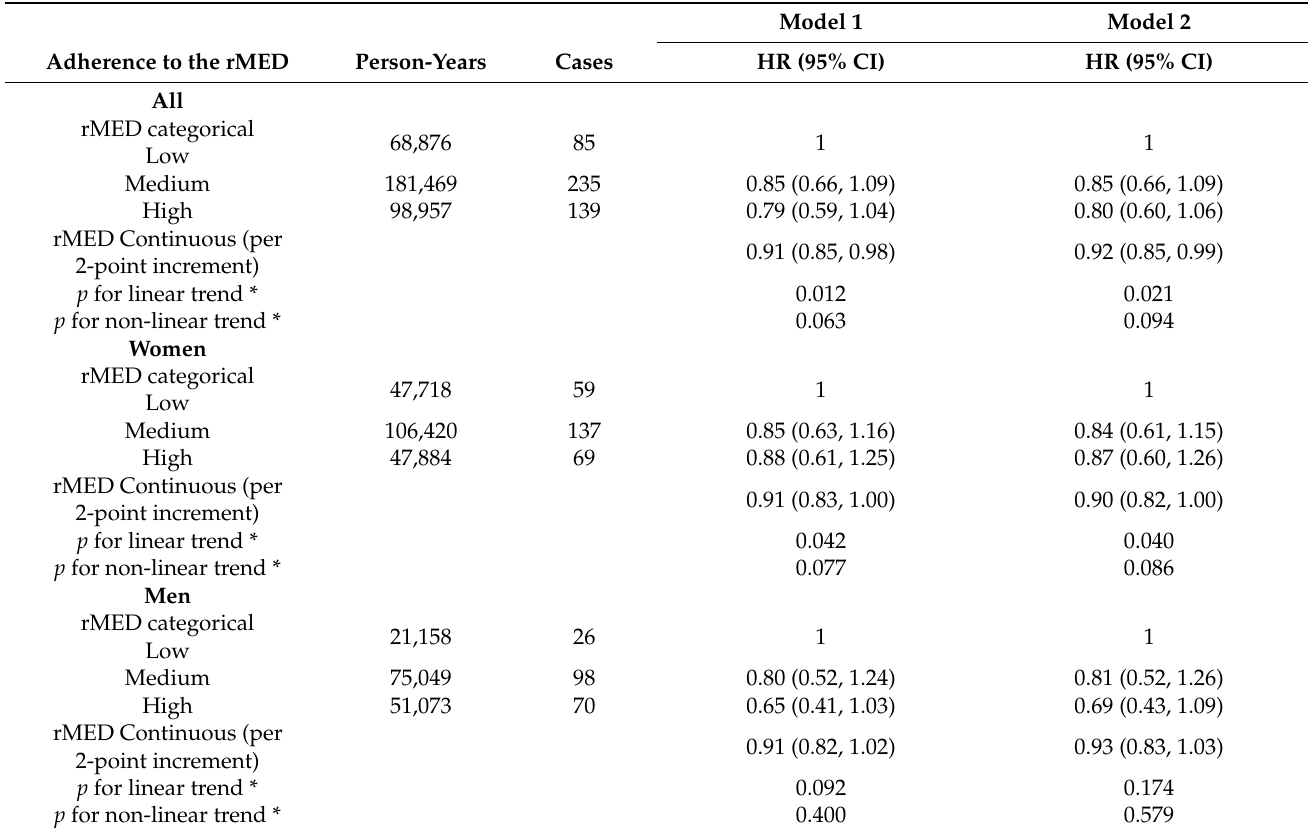
Table 2. Hazard ratio of dementia by levels of the Mediterranean Diet score (rMED) in participants from the EPIC-Spain Dementia Cohort study ( N =